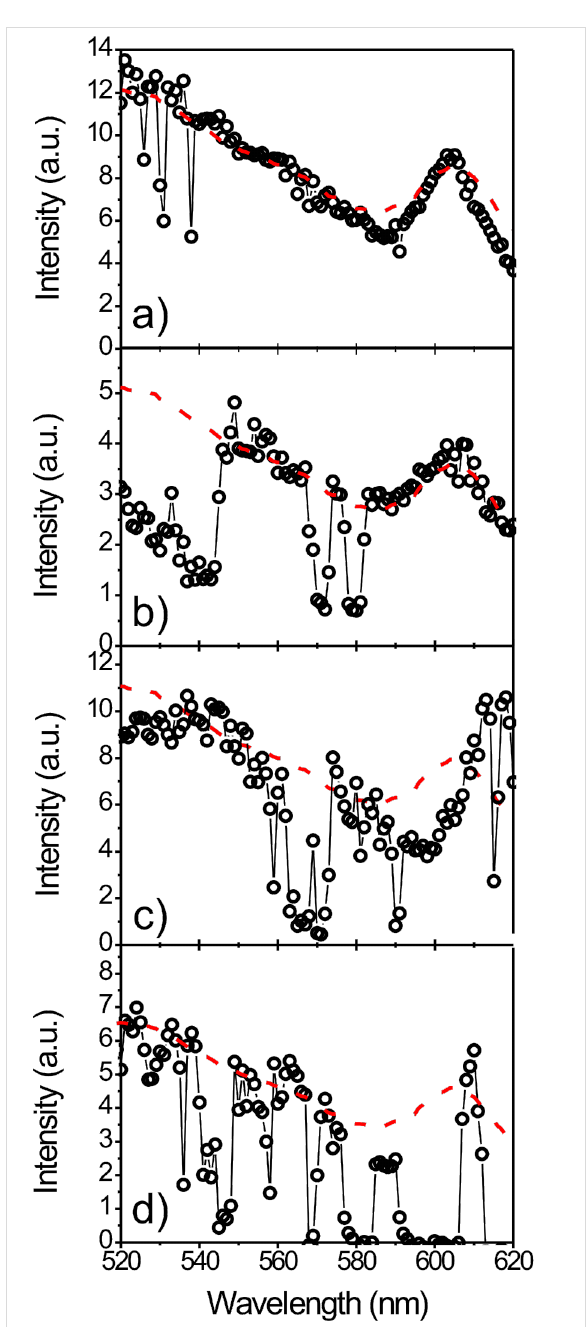
Figure 2: Single QD photoluminescence excitation spectra. For com- parison, the ensemble excitation spectrum is shown as the red dashed line. The spectra show varying degrees of emission intermittencies visible as drops and gaps in the spectra. Especially in the wavelength region of the pronounced 1S(e)-2S 3/2 (h) transition the spectra show distinct differences between different quantum dots, reflecting the indi- vidual nature of each quantum